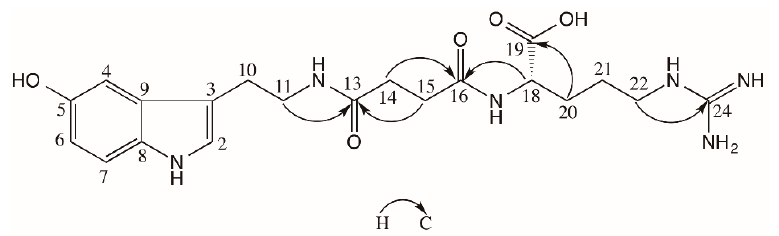
Figure 1. Key HMBC correlations of compound 1 .